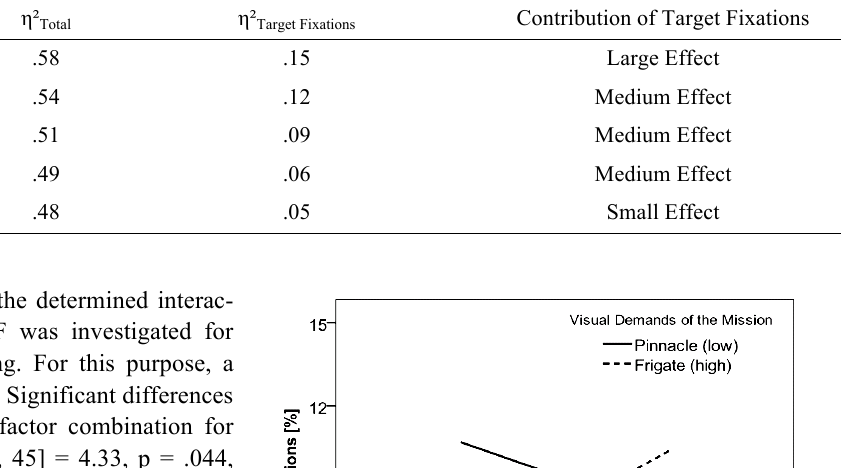
Explained Variance for a Variation of the Target Fixation Cut-Off Value Cut-Off Value [ms] η² Total η² Target Fixations